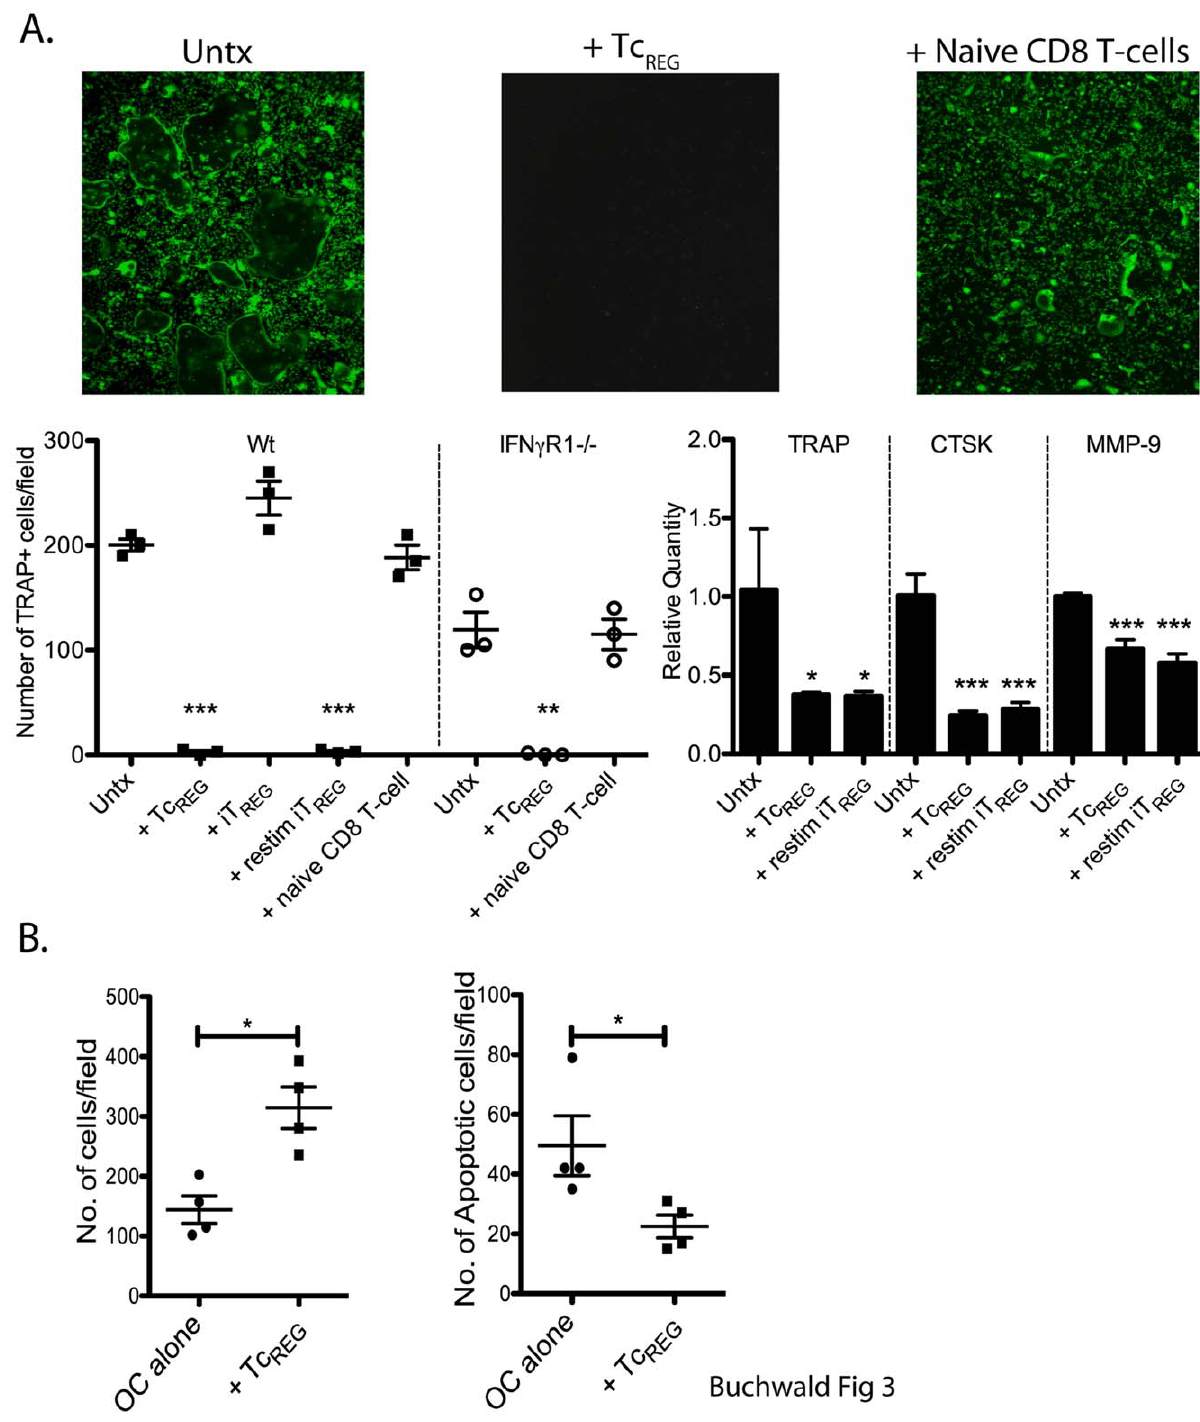
Figure 3. Osteoclast-induced Tc REG inhibit osteoclast differentiation, but not survival. A . Osteoclast precursor cells (day 0) were cultured alone, with pre-differentiated Tc REG , iT REG , anti-mouse CD3/CD28 re-stimulated iT REG , or with naı¨ve T-cells in the presence of GST-RANKL. After four days, non-adherent cells were removed by aspiration and remaining cells were stained with a fluorescent TRAP substrate ELF-97. Representative images from four experiments are shown in top panel, and quantitated cells counts are shown below. To test if suppression of osteoclastogenesis was mediated solely by IFN- c , bone marrow cells from IFN c R1 2 / 2 mice were used. The results of TRAP staining were confirmed by quantitative real- time PCR using primers for Acp5 (TRAP), Cathepsin K (CTSK) and matrix metalloprotease-9 (MMP-9). b -actin expression was used for normalization. B . Osteoclasts, cultured in the absence or presence of Tc REG for five days were counted after TRAP staining with ELF-97. To test for increased apoptosis adherent cells were stained with Annexin V. Each data point is average of three wells per experiment. Statistical significance was assessed by non- parametric paired T test: *: P , 0.05, **: P , 0.01 and ***: P , 0.001 by comparison to untreated (Untx) osteoclast wells.